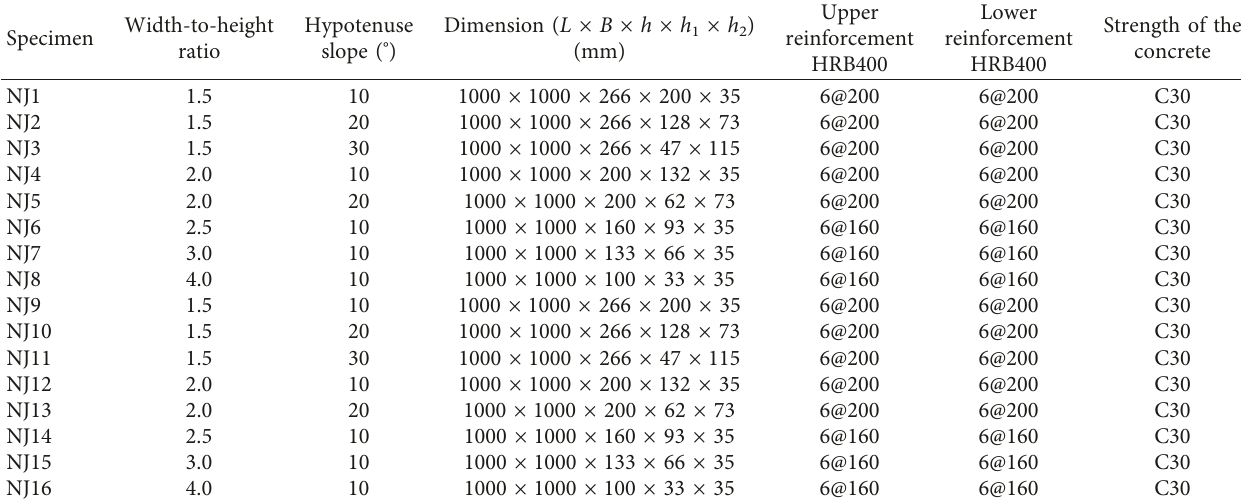
Table 1: Details of specimens.